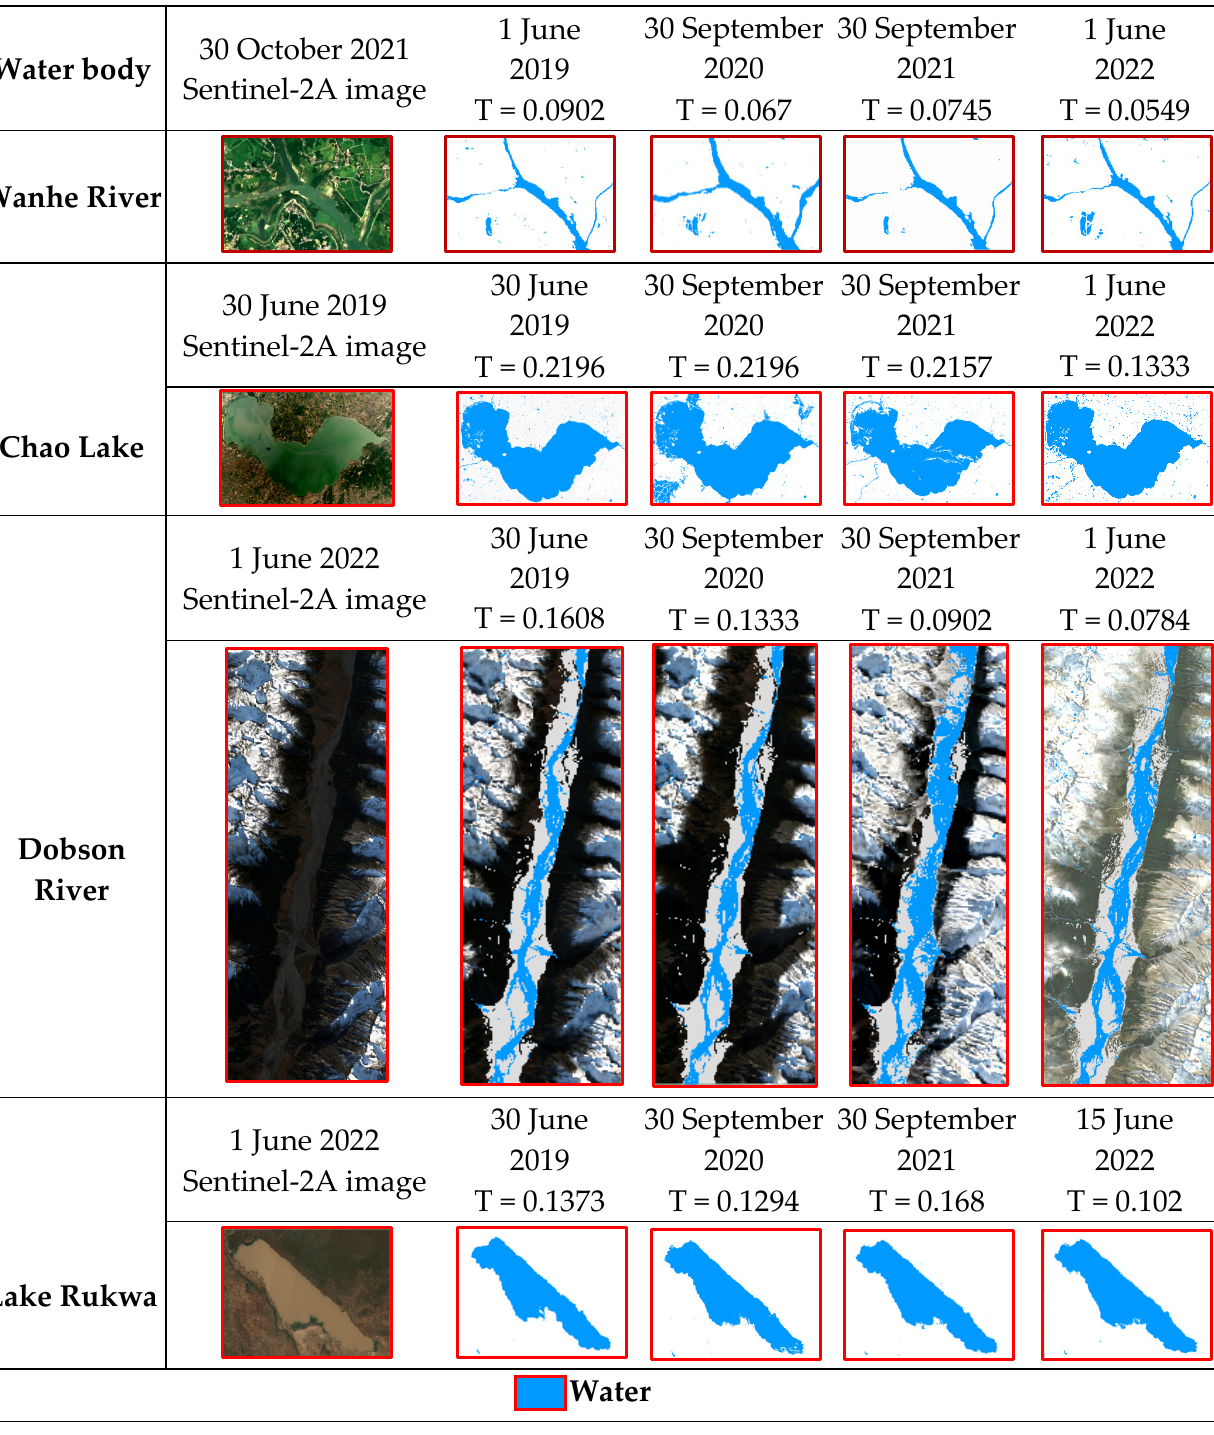
Figure 7. Water extraction on multitemporal imagery based on the TWI method at different test sites. Sentinel-2A images are resampled to 10 m GSD. Color composites, bands 4, 3, 2 coded RGB.